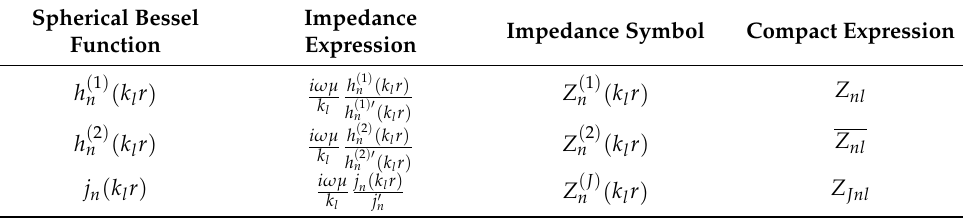
Table 1. Definitions of the different wave